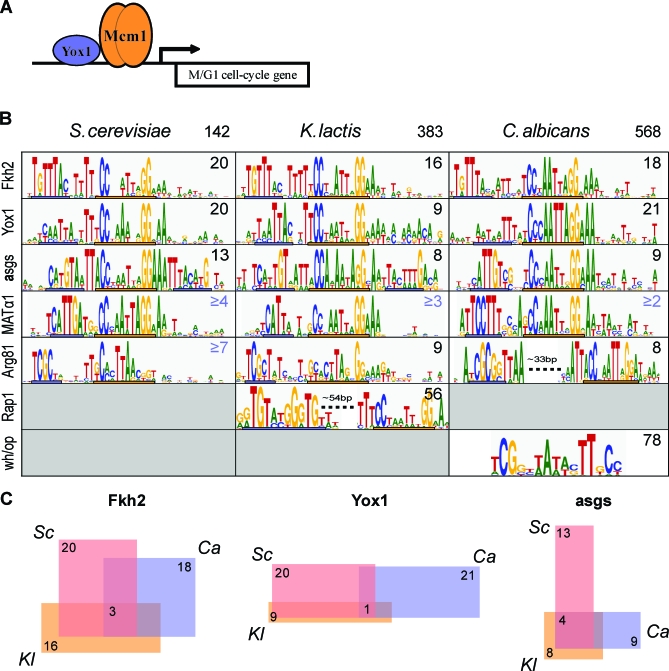
Comparison of Mcm1–Cofactor Regulons across Species(A) An example schematic of the Mcm1 homodimer and its cofactor, Yox1, binding in close proximity upstream of an M/G1-specific cell cycle gene.(B) Mcm1 associated cis-regulatory motifs discovered across the three species in this work. Each row of the table specifies an Mcm1–cofactor regulon and each column a species. The total number of Mcm1-bound regions in each species is listed in the header row. The number of Mcm1 bound regions assigned to each Mcm1–cofactor regulon in each species is listed in the upper right corner of each cell of the table; numbers colored black are based on Mcm1 ChIP data, whereas those in blue are not and are therefore more tentative. Mcm1 binds or is predicted to bind the consensus sequence denoted by the orange bar in each cell. The known or predicted cofactor motif is denoted by a blue bar in each cell. Motif graphics were generated with WebLogo [66].(C) The three-way overlap of target genes in the Fkh2-Mcm1, Yox1-Mcm1, and asg (Mcm1-a2 or Mcm1-α2) regulons in the three species (Sc = S. cerevisiae, Kl = K. lactis, and Ca = C. albicans).